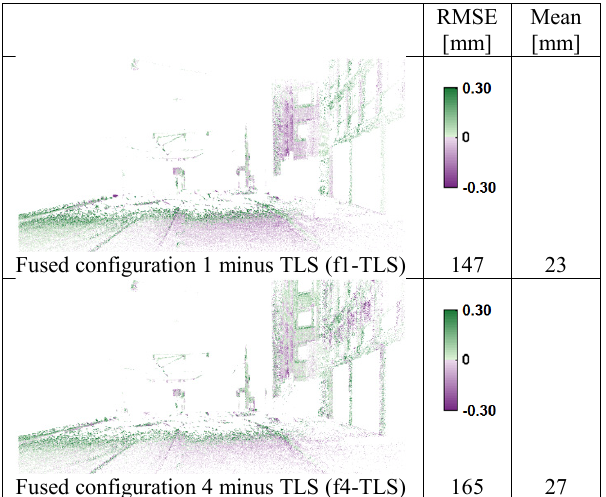
Table 6. Filtered and fused point clouds (several base images, Figure 9 and Figure 10) minus